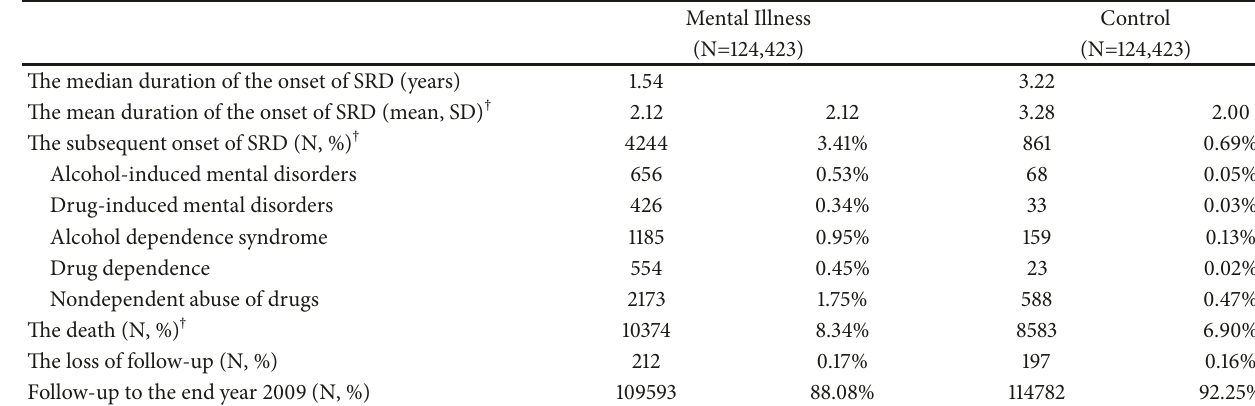
Table 2: The follow-up profiles between the mental illness and the control